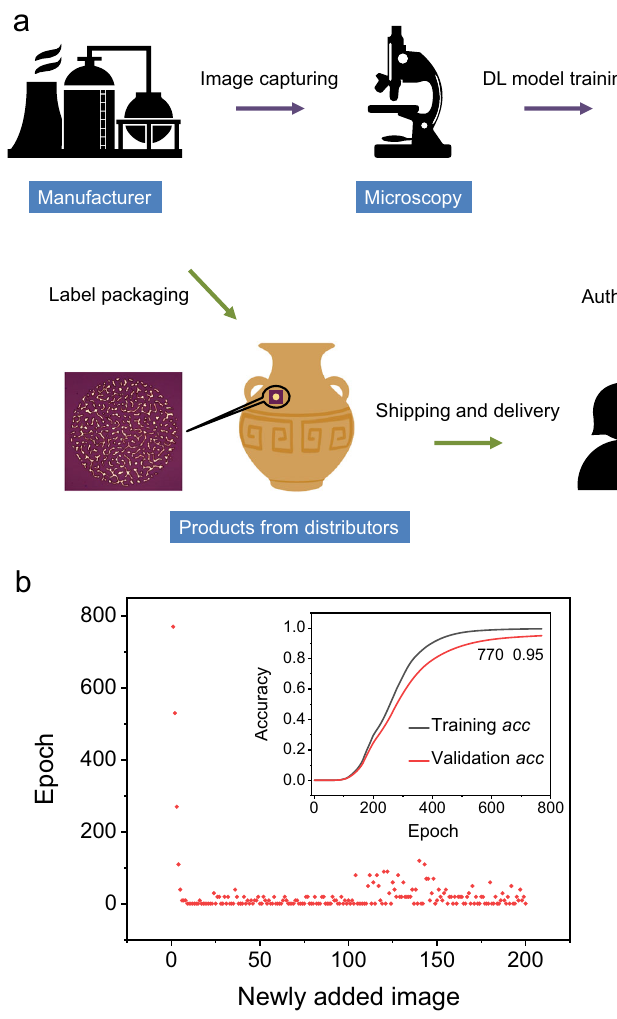
validation accuracy of the classi fi cation model with the fi rst newly added image. The training stops when the validation accuracy reaches the threshold of 0.95 (within 770 training epochs), and acc represents the accuracy. c Ratio of correct validation,wrongvalidation,andinvalidationofthe37,000imagesasafunctionof similarity threshold. The 0% wrong validation can be achieved beyond the thresholdof 0.5. 0.7 is the idealmaximum ratioof correctvalidation, asthe whole test dataset contains 30% fake